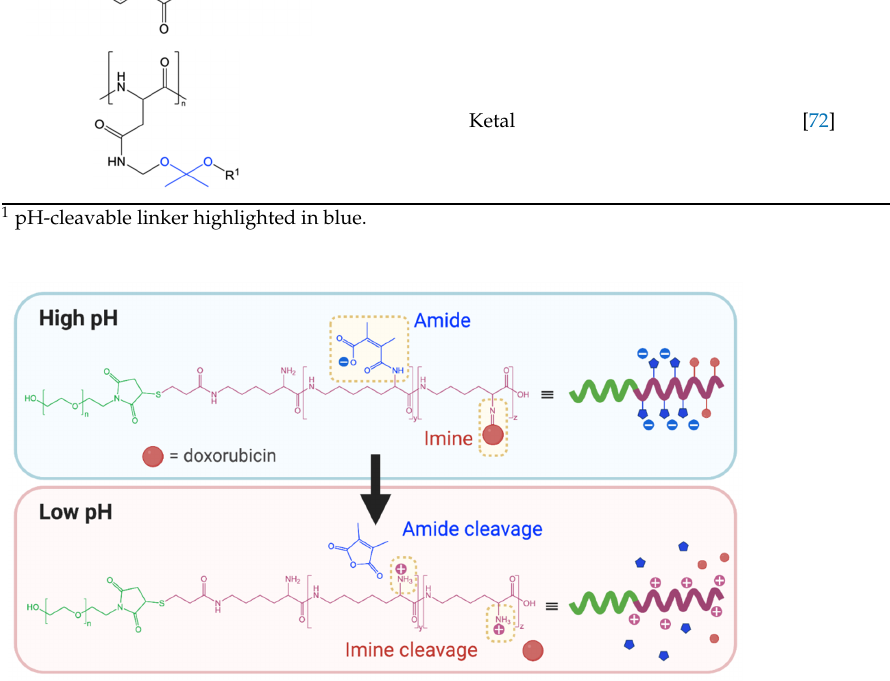
Figure 4. Dimethyl maleic anhydride and doxorubicin grafted to PEG- b - ɛ- poly( L -lysine) through amide and imine bonds, respectively, prepared by Guo et al. At pH 5.0–6.8, cleavage of the pH- labile amide and imine bonds results in charge reversal and drug release (adapted from [61]